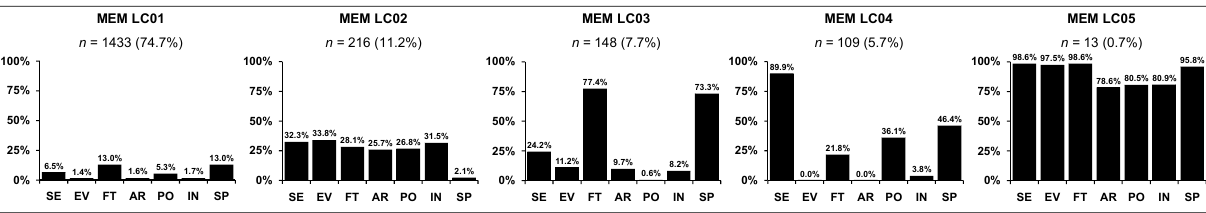
Figure 6. Membership-based cluster summary. X-axis labels: SE = community service clubs; EV = environmental; FT = fitness and outdoor recreation; AR = community arts; PO = political; IN = internationally-oriented; SP =